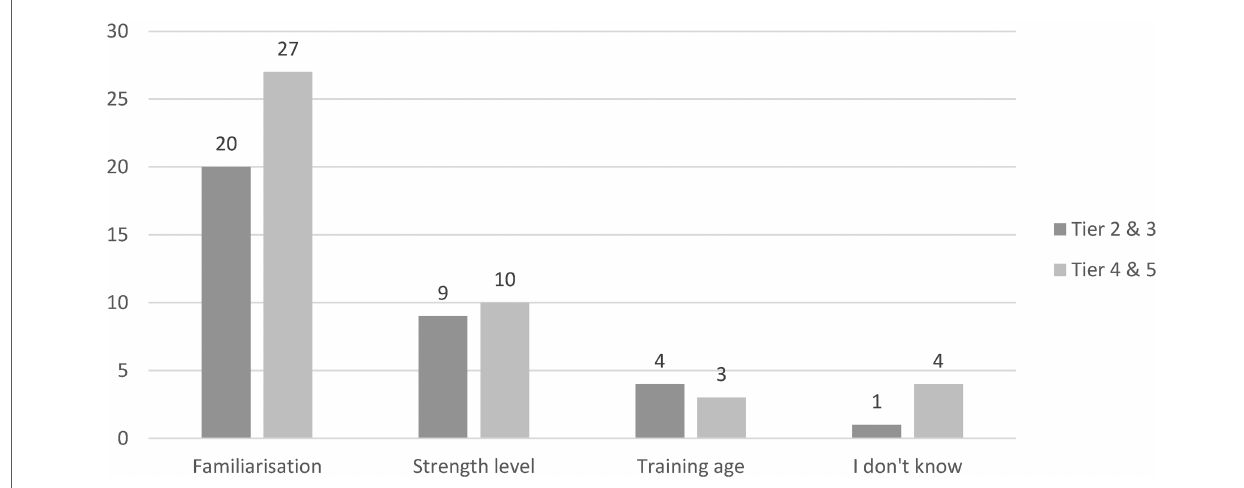
FIGURE 1 The prerequisites to fl ywheel training according to therapists with responses tiered by the level of athlete (classi fi ed using a framework [23]). N